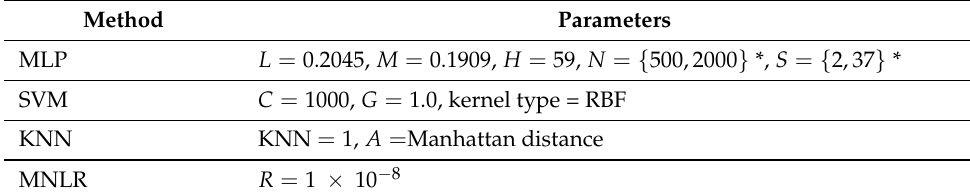
Table 7. Second experiment: classifiers’ configuration for the first test.